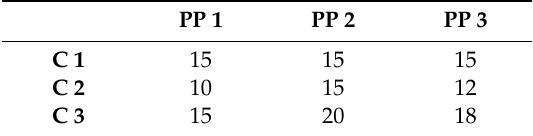
Table A3. Distance between Coal Sources and Power Plants in